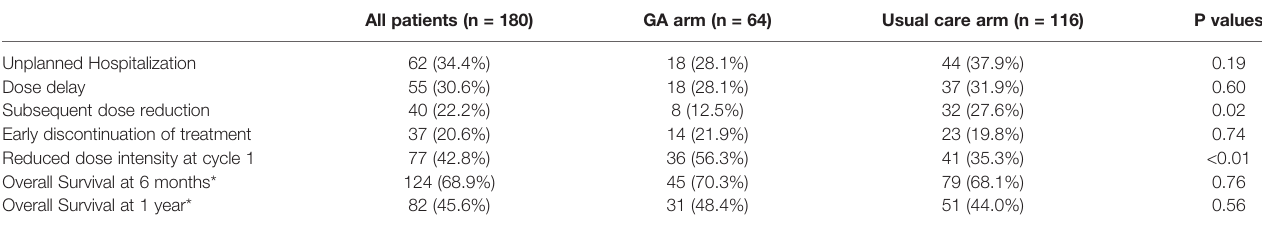
TABLE 2 | GAP Study Lung Cancer Treatment Secondary Outcomes by Study Arm. All patients (n = 180)